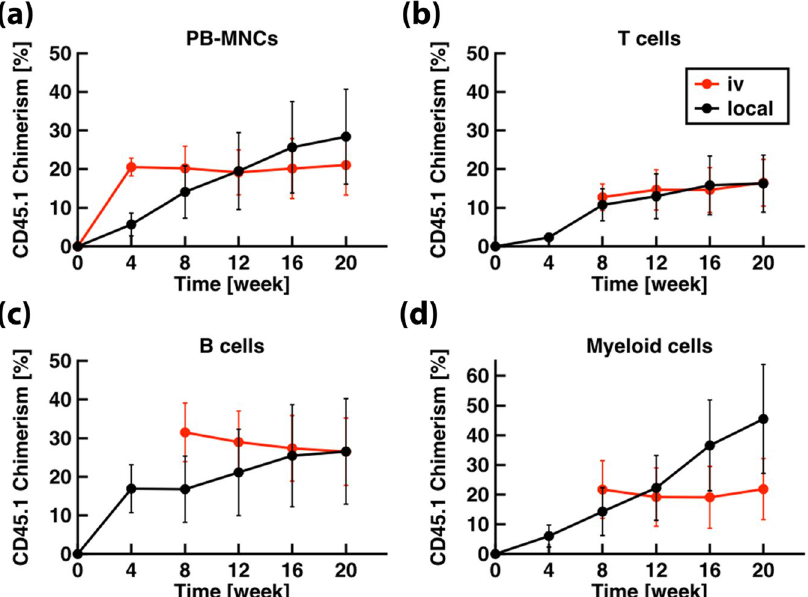
Figure 5. Long-term multi-lineage hematopoietic reconstitution. The dynamics of peripheral blood reconstitution for ( a ) peripheral blood mononuclear cells (PB-MNC), ( b ) T cells, ( c ) B cells, ( d ) and myeloid cells (CD11B + ) is shown as the average chimerism as a function of time after transplantation of a single Tie2 + CD150 + CD48 low/ − CD135 − LKS HSC (n = 5,